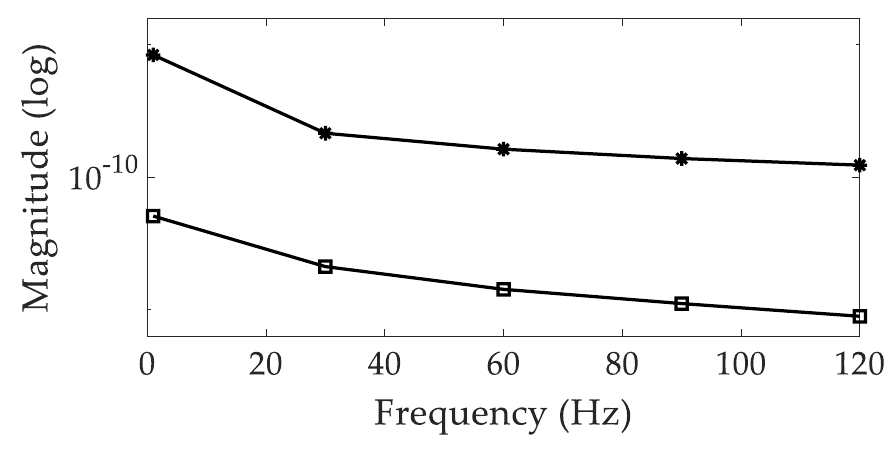
Figure 4. FRF of the theoretical power plant model.